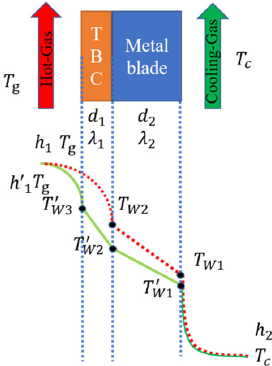
Figure 1. 1 ‐ D heat transfer model. Figure 1. 1-D heat transfer